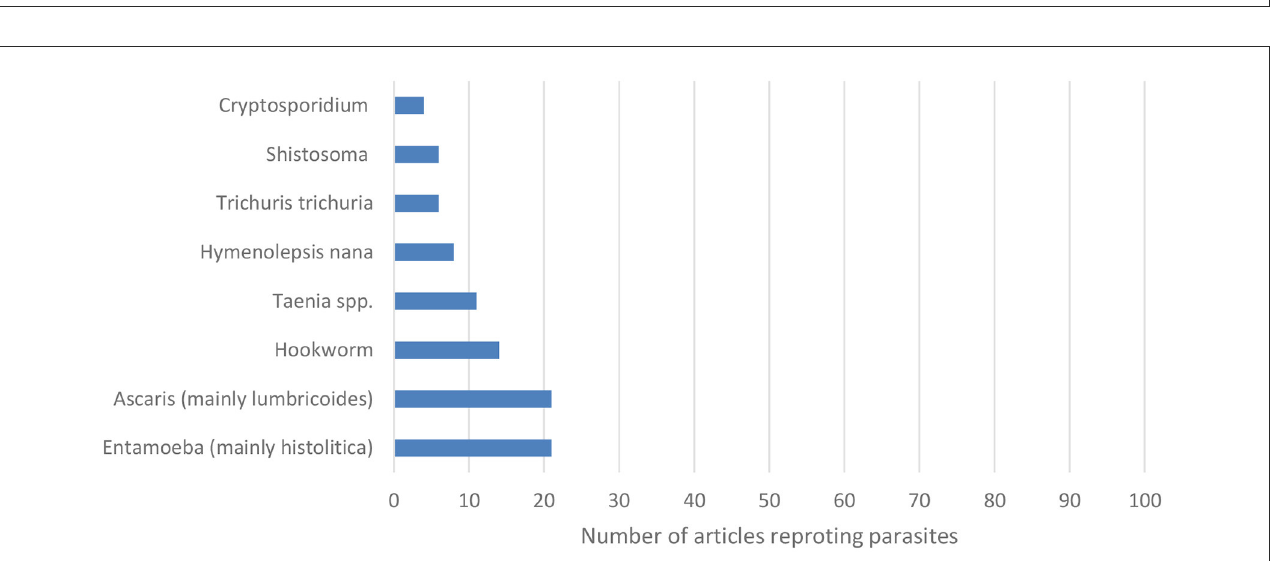
FIGURE5 Number of articles reporting a particular parasite. Numbers are derived from every article investigating on parasites. That is an article may report more than one